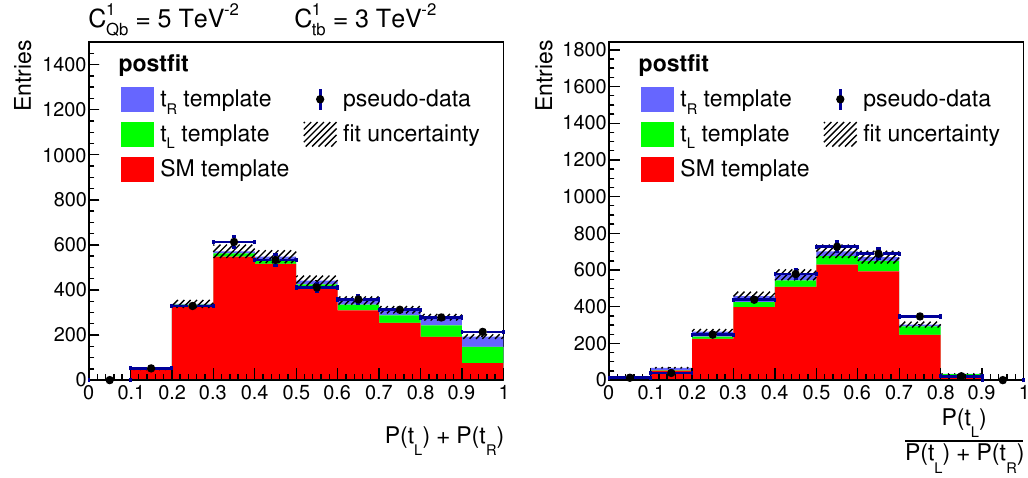
Figure 15 . Projected distributions of the (cid:12)tted templates and one of the generated pseudo-datasets onto the P ( t L ) + P ( t R ) axis (left) and onto the P ( t L ) axis (right). The P ( t L )+ P ( t R )